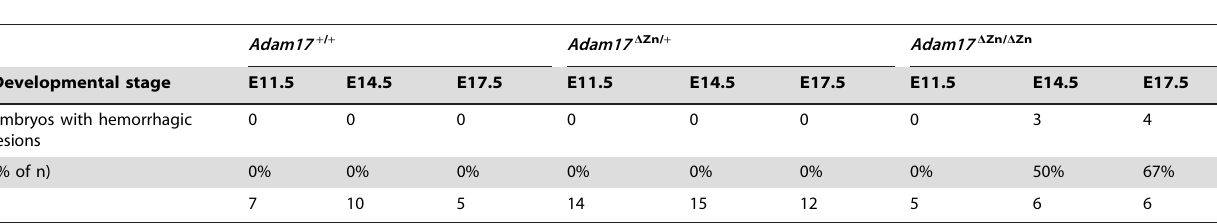
Table 1. Hemorrhagic Lesions in Littermates Derived from Adam17 D Zn/ +